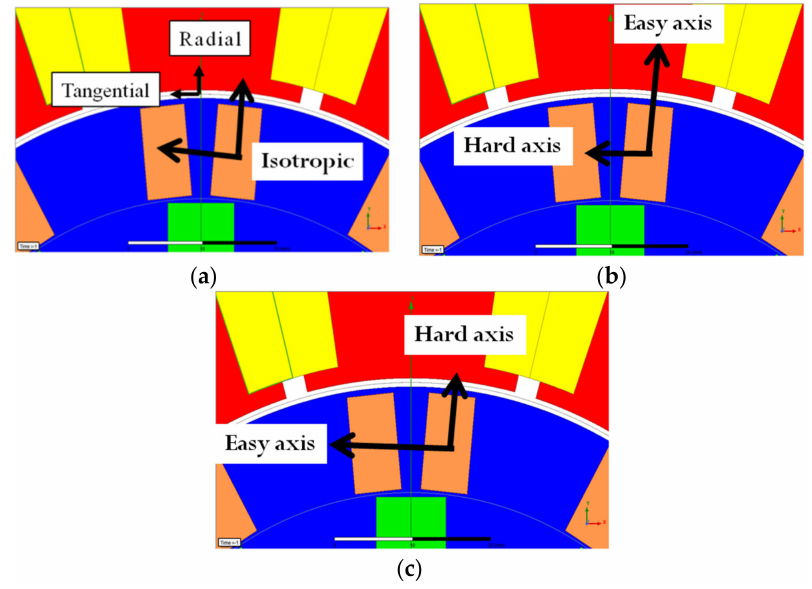
Figure 2. ( a ) Isotropic variable-flux spoke-type permanent magnet synchronous motor (VFS-PMSM), ( b ) Anisotropic Topology I, and ( c ) Anisotropic Topology